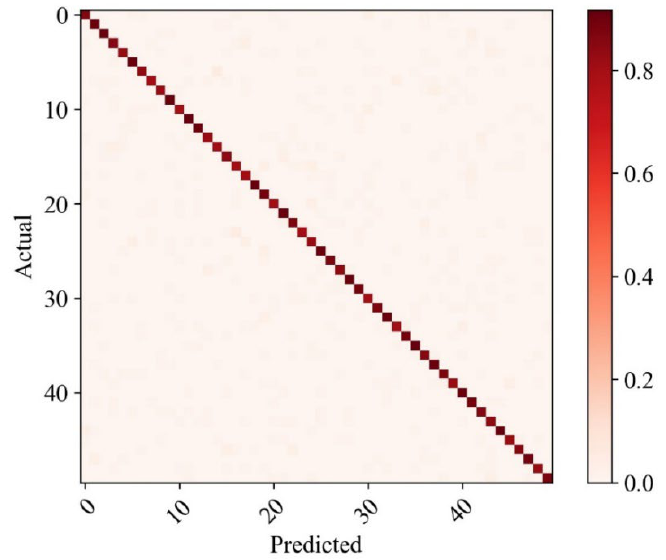
Figure 8. Confusion matrix on AF - bird50.